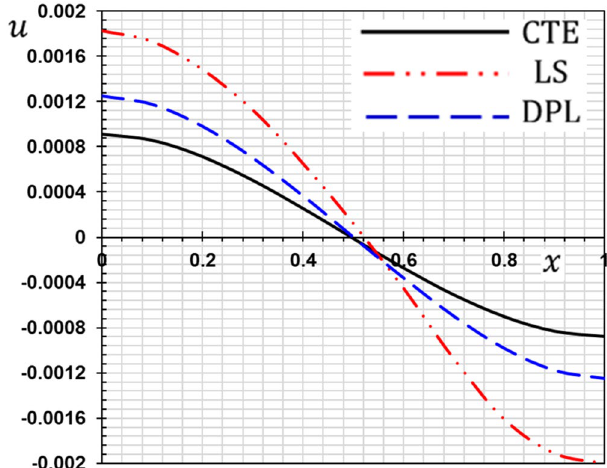
Figure 12. The displacement with different thermoelastic models.